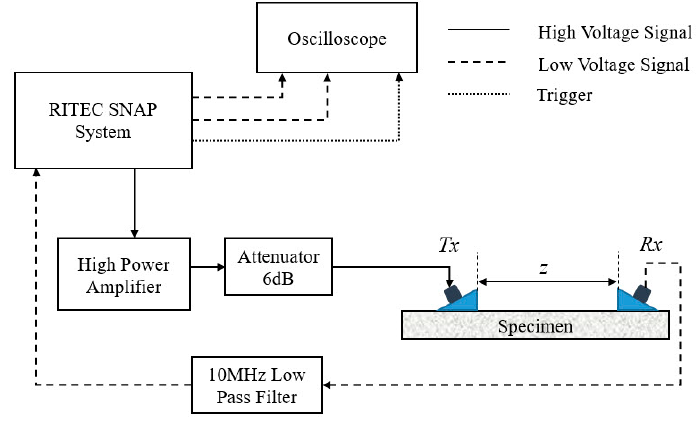
Figure 4. Experimental setup.